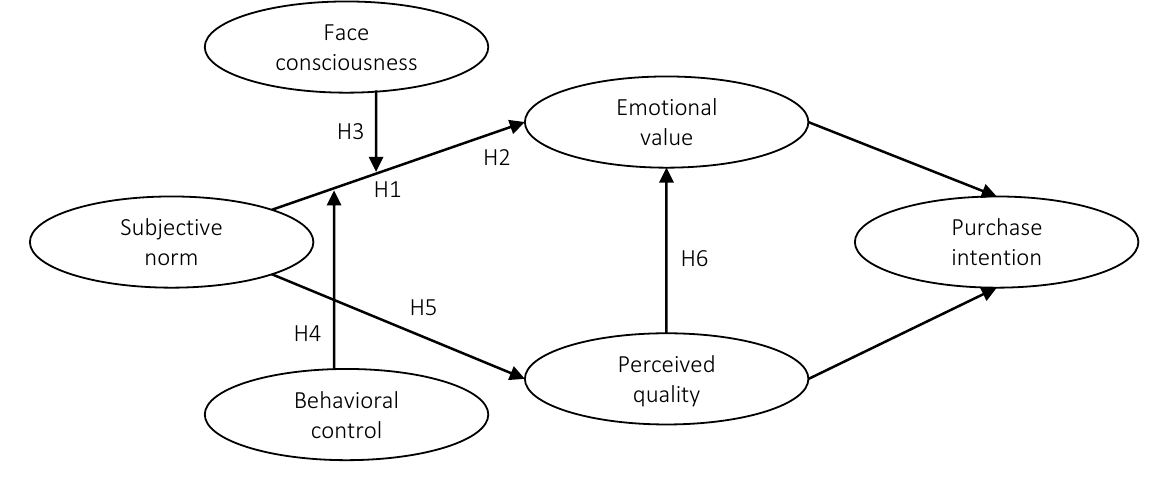
Figure 1. Conceptual framework